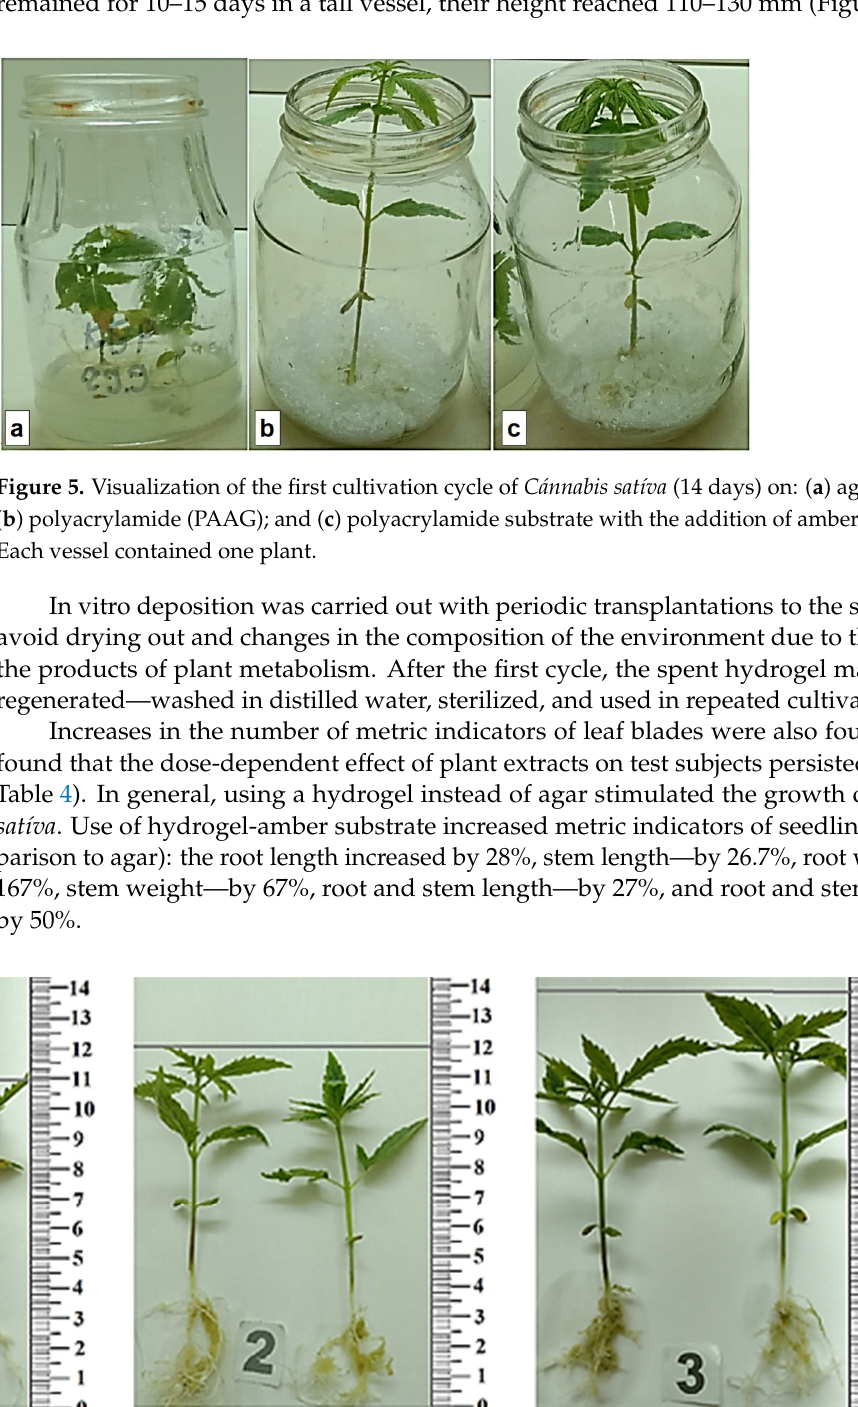
Figure 6. Metric indicators of Cánnabis satíva seedling growth: ( 1 ) on agar substrate; ( 2 ) on polyacrylamide substrate (PAAG); ( 3 ) on polyacrylamide substrate with amber addition (PAAG- A2).